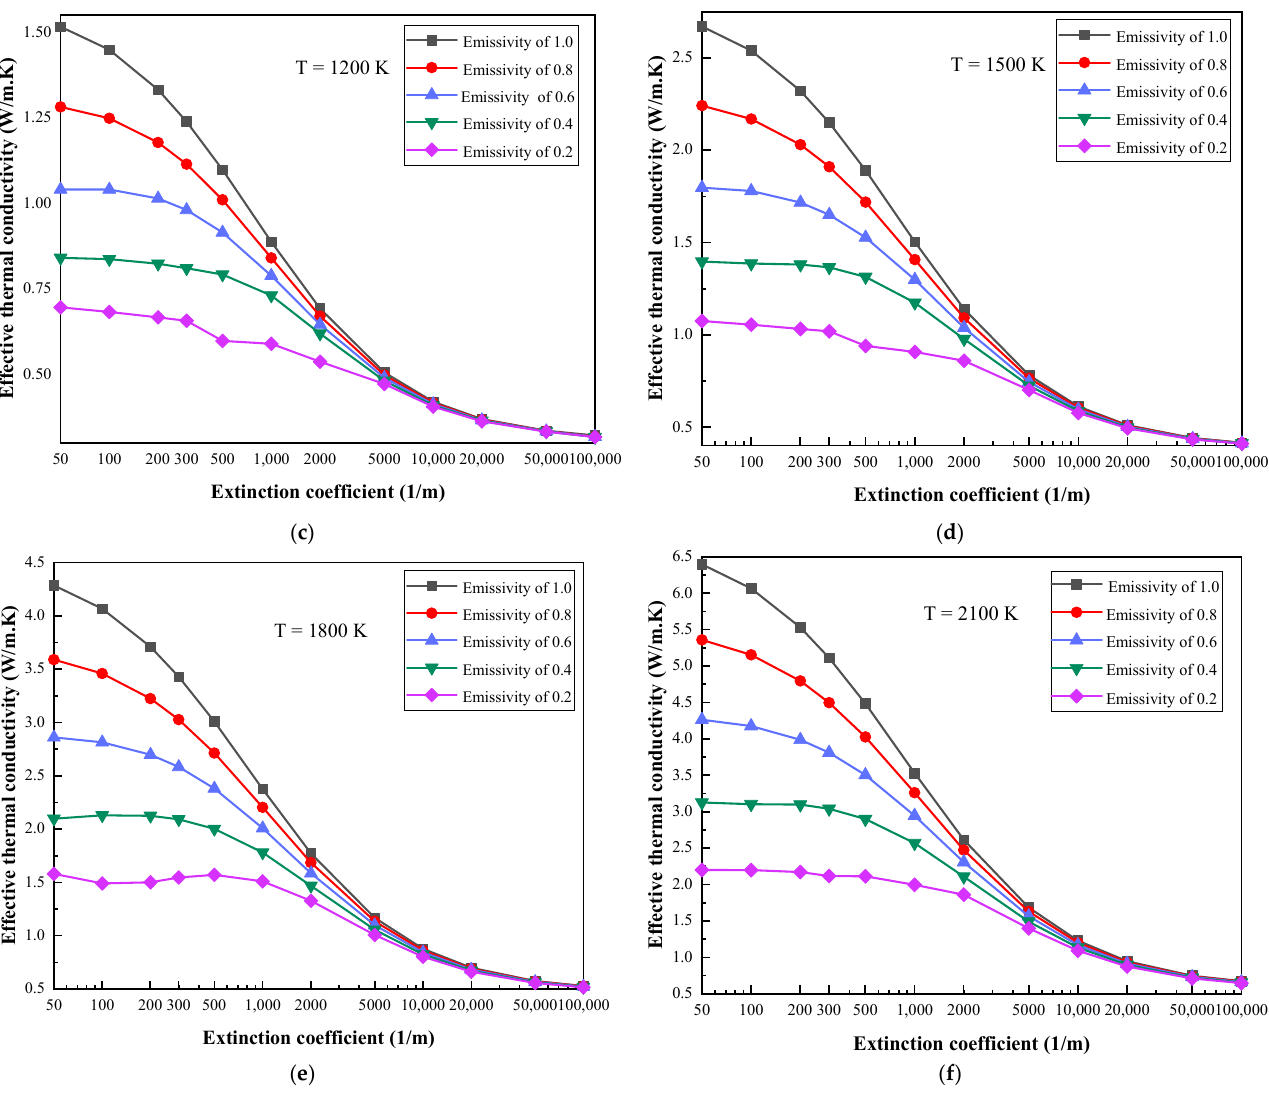
Figure 1. The variation in ETC values with different extinction coefficients: ( a ) T = 600 K, ( b ) T = 900 K, ( c ) T = 1200 K, ( d ) T = 1500 K, ( e ) T = 1800 K, ( f ) T = 2100